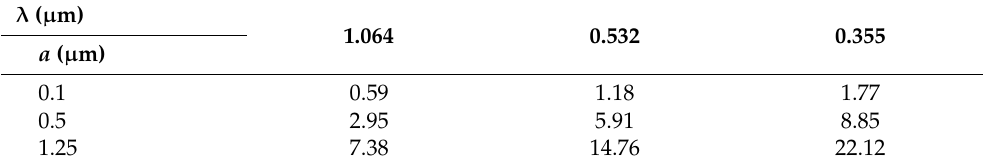
Table 2. Size parameter, x for different values of particle radius and incident wavelength. λ ( µ